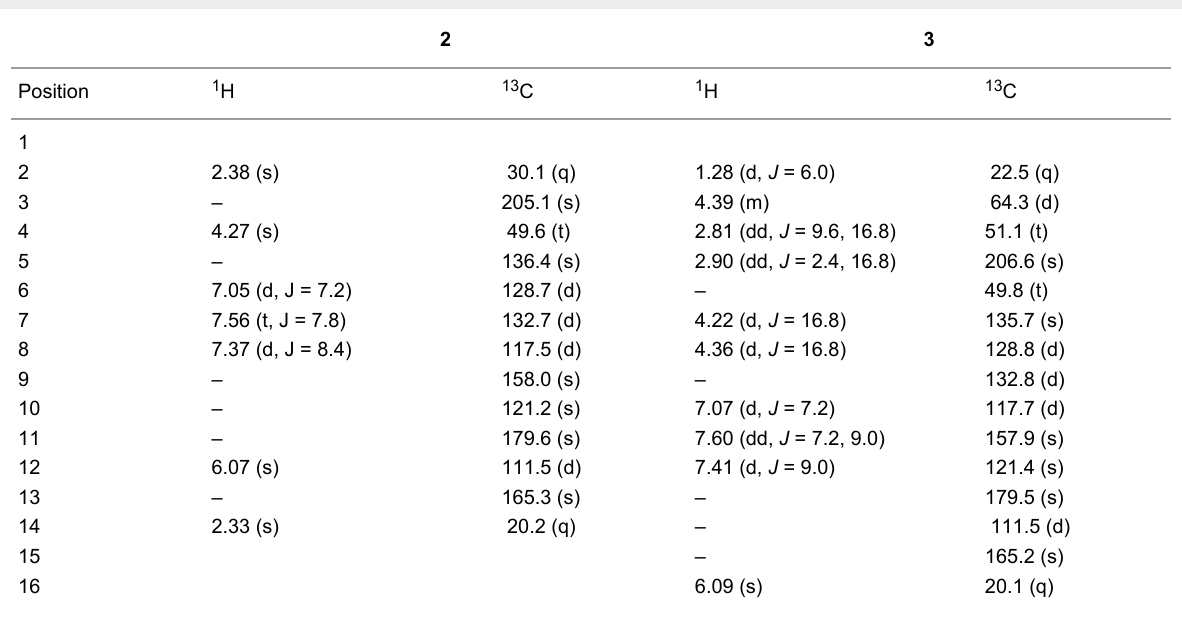
Table 2: 1 H, 13 C NMR Data of 2 and 3 at 600, 150 MHz, in CDCl 3 , δ in ppm, J in